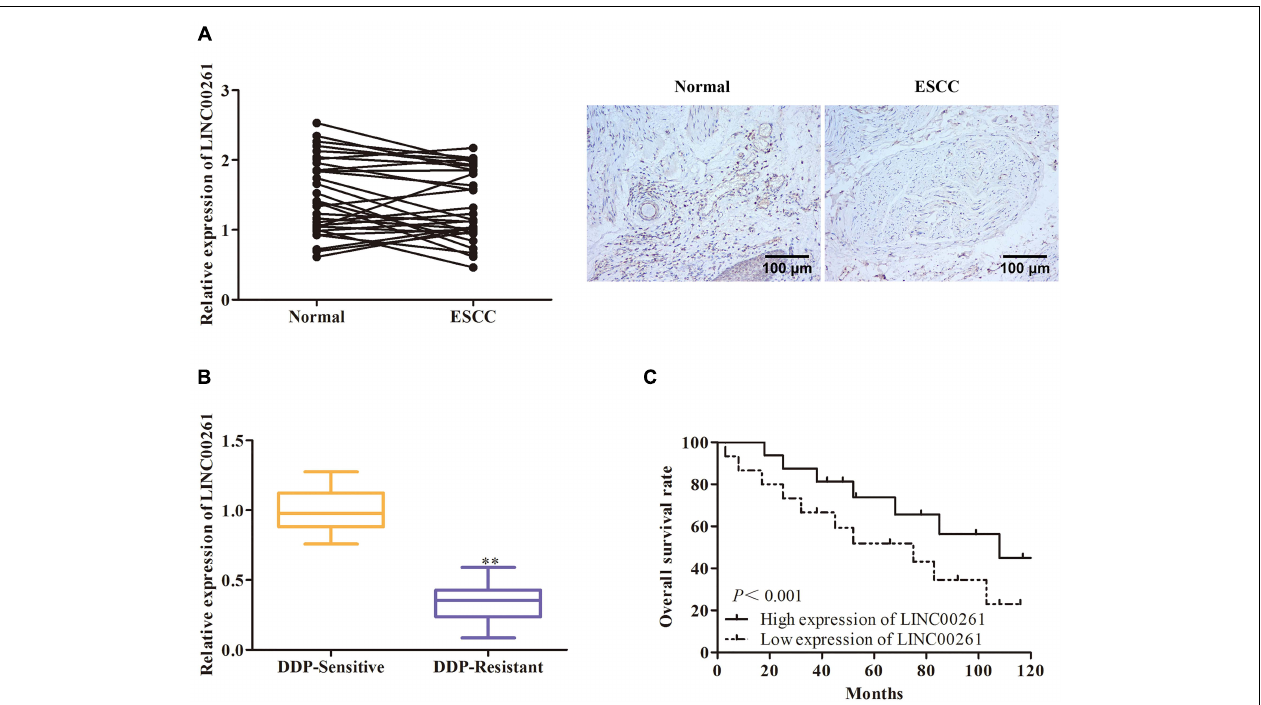
FIGURE 1 | LINC00261 expression is decreased in ESCC tissues and ESCC cells. (A) The expression of LINC00261 in ESCC tissues and adjacent tissues. (B) The expression of LINC00261 in DDP-sensitive and DDP-resistant ESCC patients. (C) Survival analysis based on ESCC patients with high-level or low-level LINC00261. ** P < 0.01 compared with the corresponding control